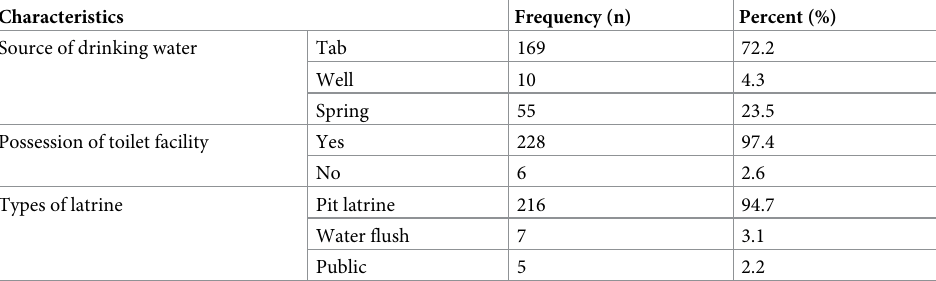
Table 2. Environmental and sanitation characteristics of pregnant women attending antenatal care at Debre Mar- kos Referral Hospital, Northwest Ethiopia,